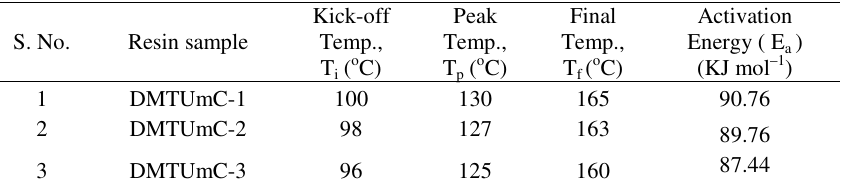
Table 3 . Curing characteristics of the DMTUmC-HMTA systems at 10 K min –1